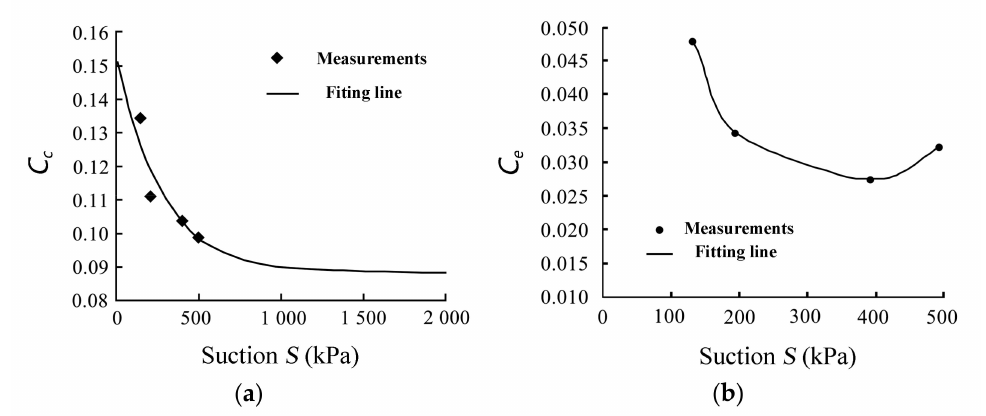
Figure 11. The compressibility of Shanghai soft soil [21,22]: ( a ) relationship between compression index C c and matric suction S, ( b ) effects of matric suction S on the resilience index C e